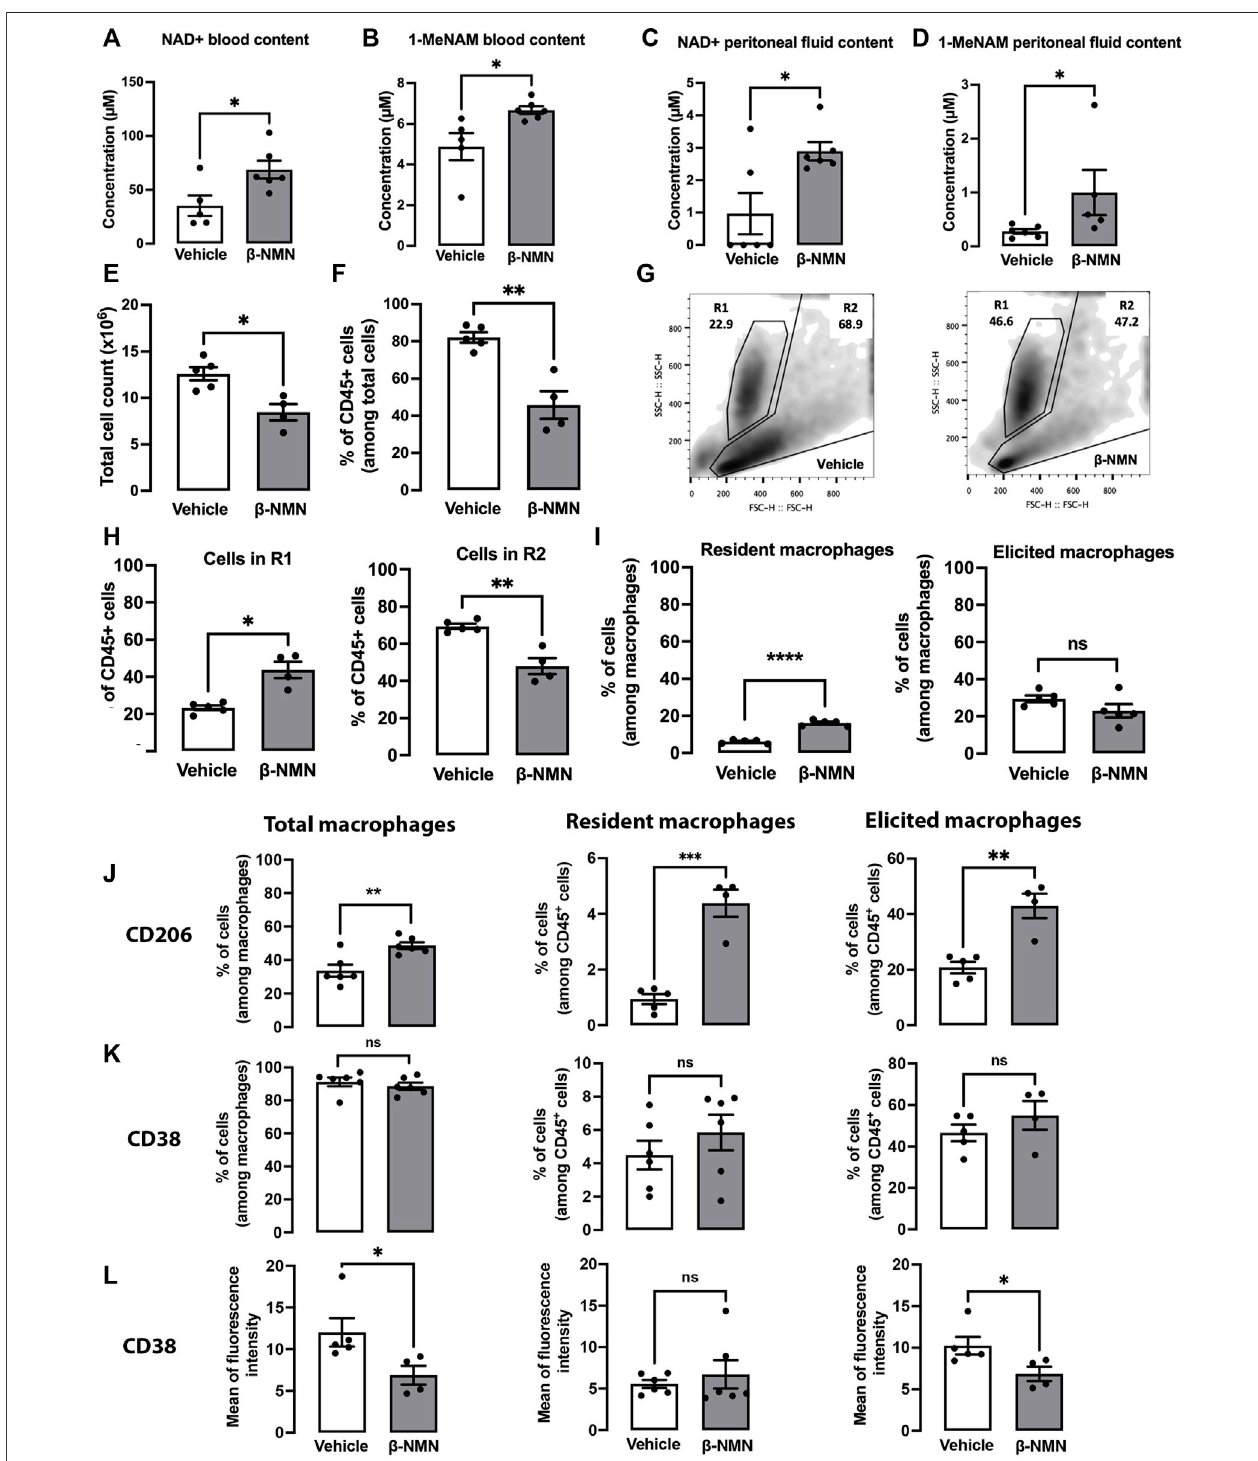
FIGURE 3 | Phenotypic characterization of peritoneal cells from mice subjected to TGC-induced peritonitis treated or not with β -NMN 3 days post TGC administration,blood,andperitonealexudatesfromvehicleand β -NMNmicewerecollected.NAD+and1-MeNAMweredosedbyUHPLC,andtheperitonealcellswere characterizedby fl owcytometry. (A – D) NAD+and1-MeNAMcontentsofblood (A,B) andperitoneal fl uid (C,D) ofmice. (E) Totalcellcountintheperitonealextrudatesof mice. (F) Proportion of CD45 + cells found in the peritoneal exudates. Data were expressed as a percentage of total cells. (G) Representative dot-blot of forward scatter (FS) versus side scatter (SS) of peritoneal cell populations (R1 and R2) from vehicle- (left panel) and β -NMN-treated (right panel) mice. (H) Proportion of total